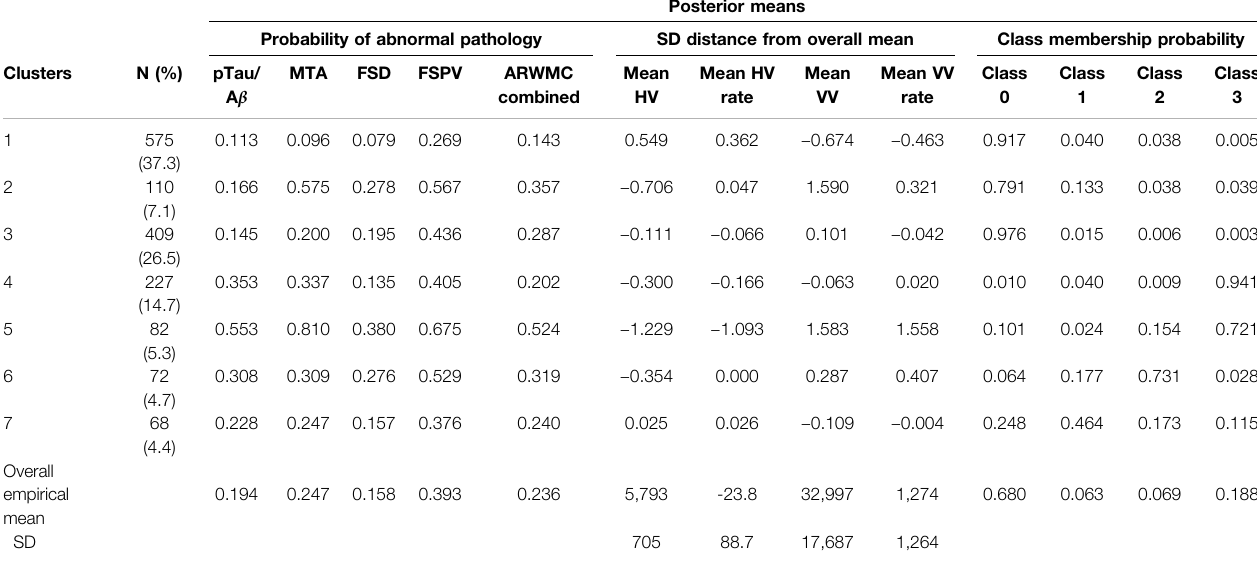
TABLE 4 | Results from the Bayesian pro fi le regression analysis on the 1,543 participants. Posterior means Probability of abnormal pathology SD distance from overall